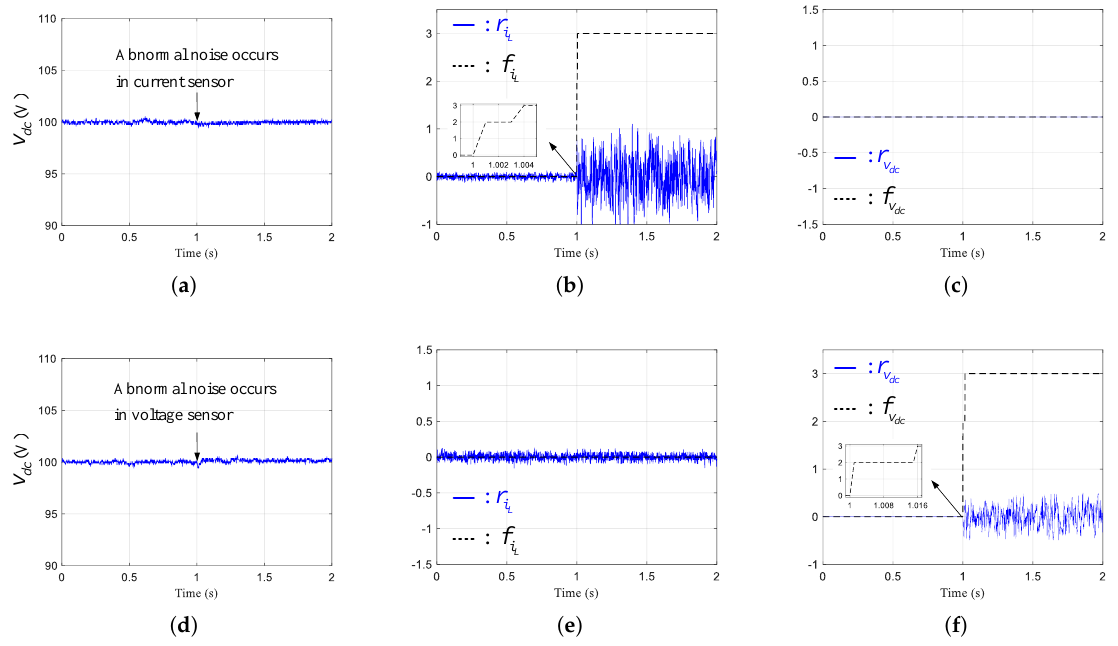
Figure 8. Output voltage, normalized residuals and fault flags of the proposed observer under an abnormal noise condition in the current sensor ( a – c ) and voltage sensor ( d – f